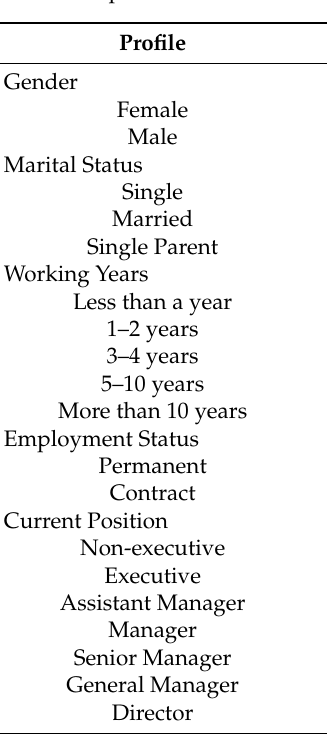
Table 1. Respondent